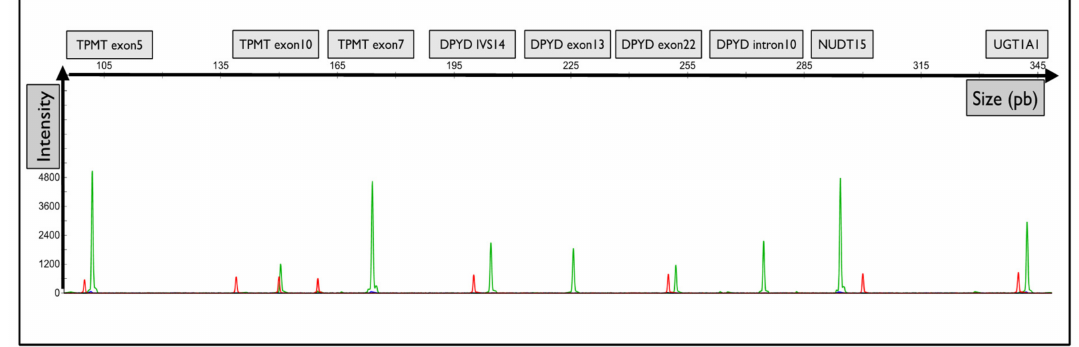
Figure 1. Representative graphical results of the migration of fragments from each gene of interest. Graphical electropherogram obtained for wild-type samples for all alleles tested. The green peak corresponds to the fluorescence of the HEX probe. The red peak corresponds to the size of the internal